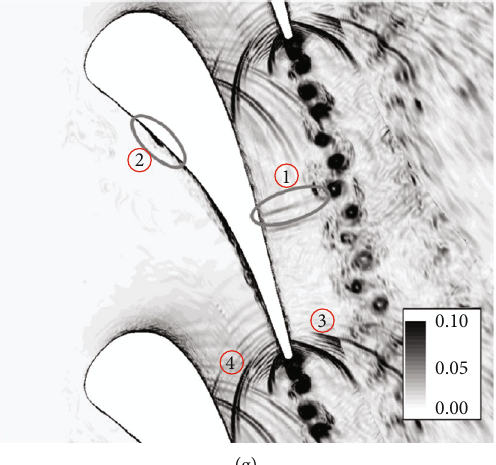
Figure 5: Dimensionless density gradient contours of fl ow condition MUR235: (a) SST-RANS result; (b) SST-URANS result; (c) Menter SST- SAS result; (d) Menter SST-DDES result; (e) present SAS result; (f) time-averaged result of present SAS; (g) LES result